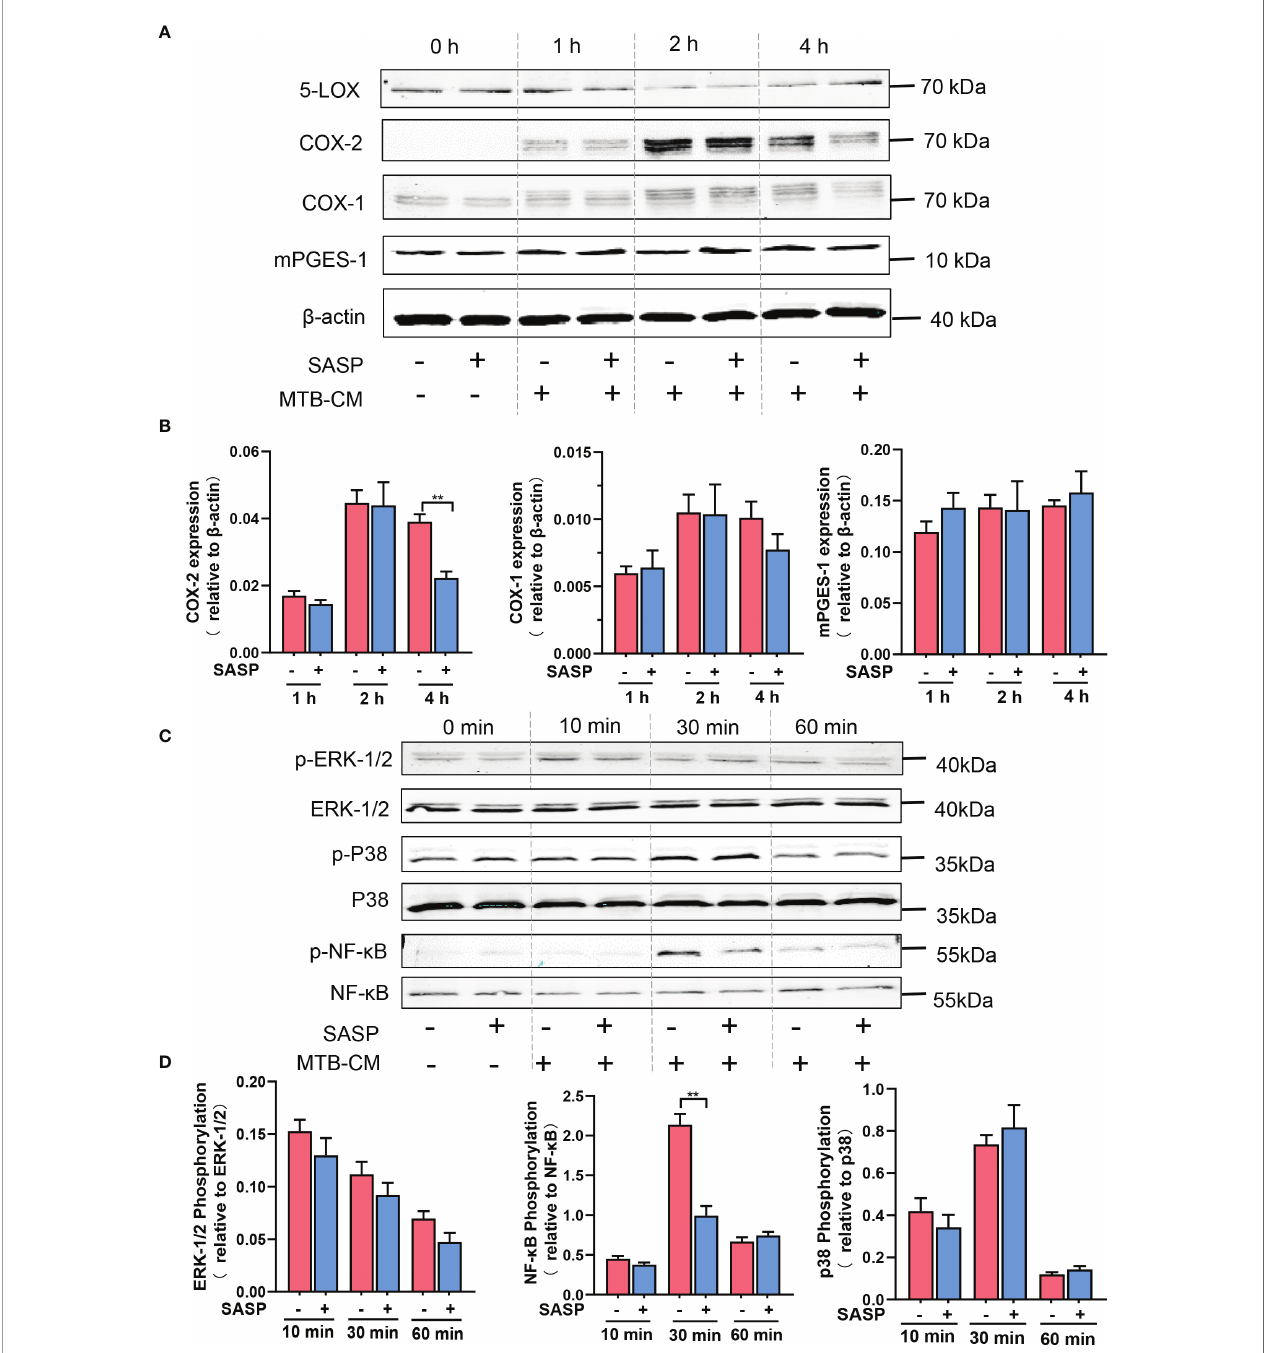
FIGURE 6 | Inhibition of COX-2 protein expression by SASP correlates with impaired phosphorylation of NF- k B p65. (A, B) Human M1-MDM were pretreated with 200 m M SASP or vehicle (veh., 0.1% DMSO) for 1 h before stimulation with MTB-CM (1%) for 0, 1, 2 or 4h. Cell lysates were immunoblotted for COX-1, COX-2, and mPGES-1 and normalized to b -actin for densitometric analysis. Data are given as means ± S.E.M, n =3. *p ≤ 0.05, **p ≤ 0.01. (C, D) Human M1-MDM were pretreated with 200 m M SASP or vehicle (veh., 0.1% DMSO) for 1 h before stimulation with MTB-CM (1%) for 0, 10, 30 or 60 min. Cell lysates were immunoblotted for phospho-p38 MAPK, p38 MAPK, phospho-ERK-1/2, ERK-1/2, phospho-NF- k B p65, and NF- k B p65, and subjected to densitometric analysis, where signals of phosphorylated proteins were normalized to respective total amounts. Data are given as means ± S.E.M, n = 3. **p <